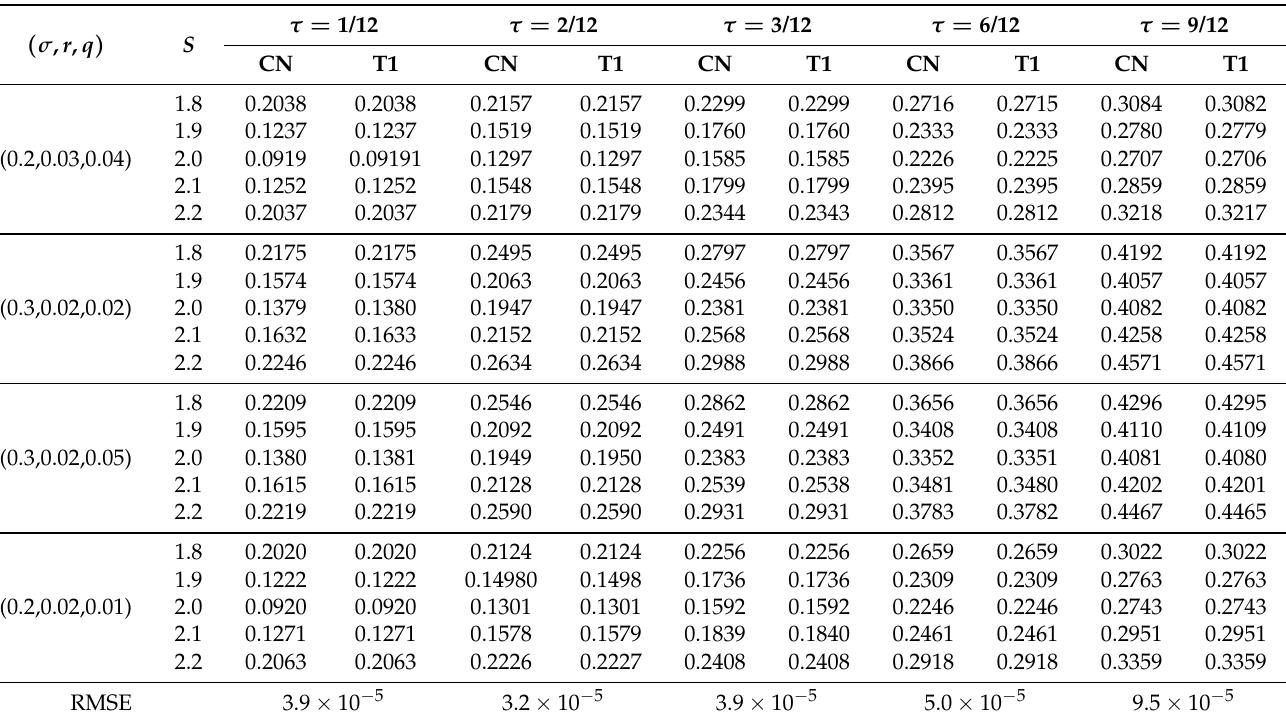
Table 1. Comparison of American straddle option prices with X = 2 using Theorem 1 (T1) and the Crank–Nicolson scheme (CN).